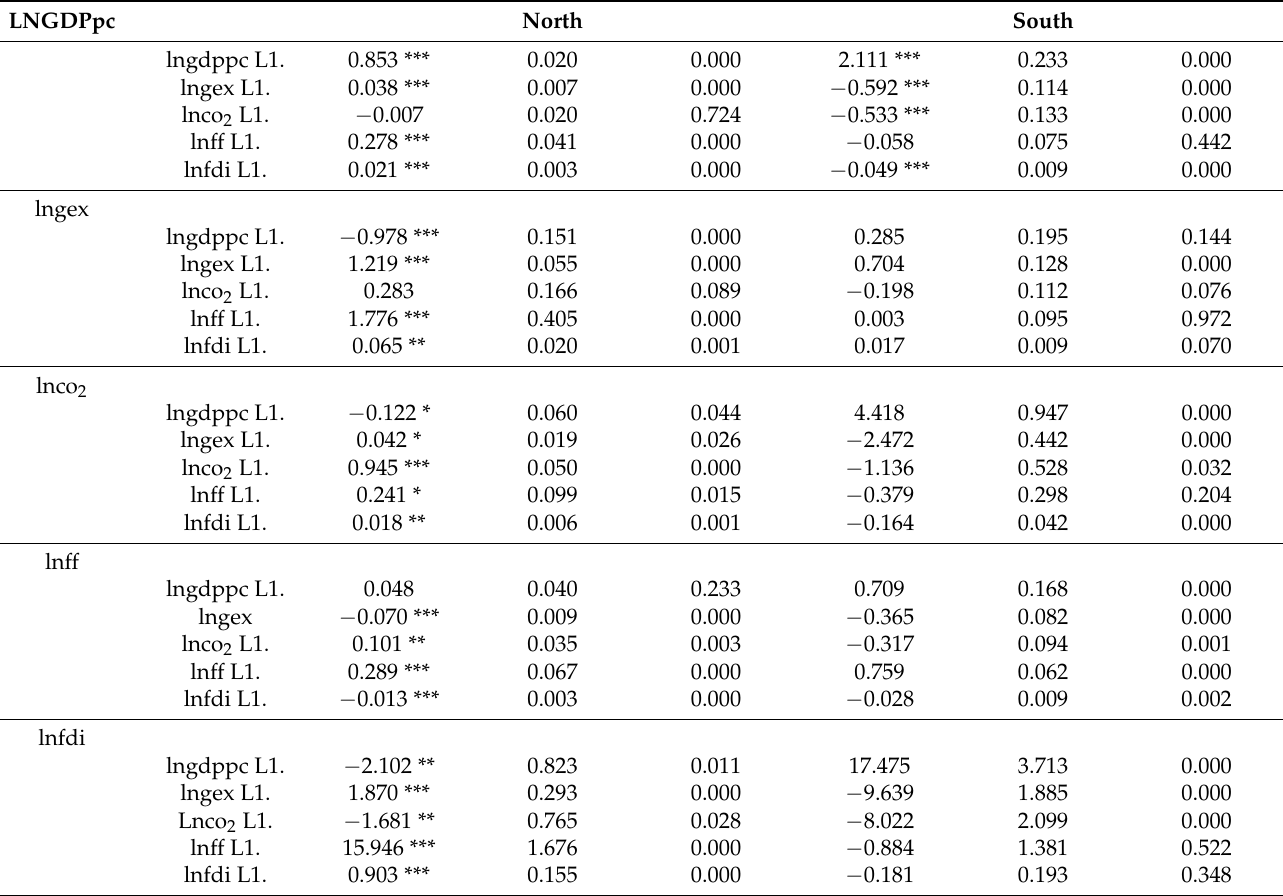
Table 6. PVAR style GMM